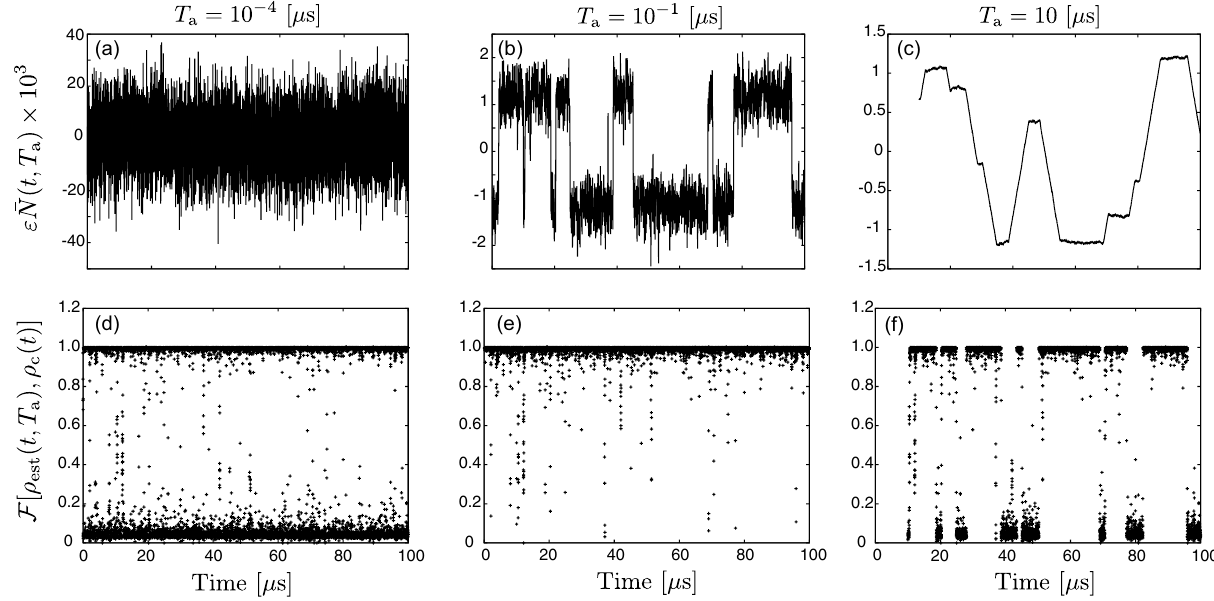
ρ est ( t , T a ) , ρ c ( t ) 10 − 4 µ s ( a , d ), T a 10 − 1 µ s ( b , e ), for T a [ ] = =